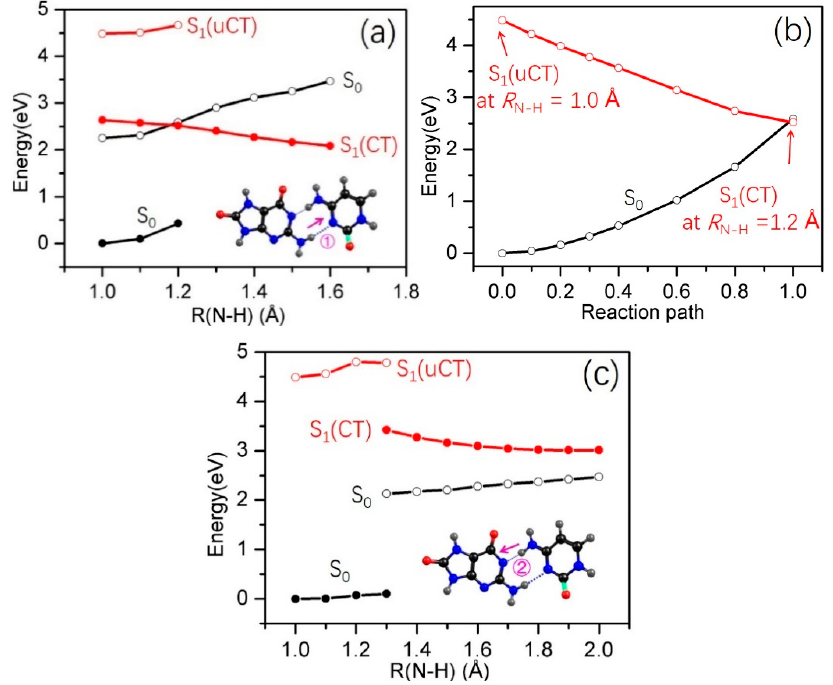
Figure 5. PE profiles of the ground state and the lowest excited states of the 8-oxo-G − -C base pair along the R N10 − H13 ( a ) and R N7 − H9 ( c ) proton-transfer coordinates; ( b ) shows the energy profiles of the LIIC path connecting S 1 (uCT) with S 1 (CT) in ( a ).